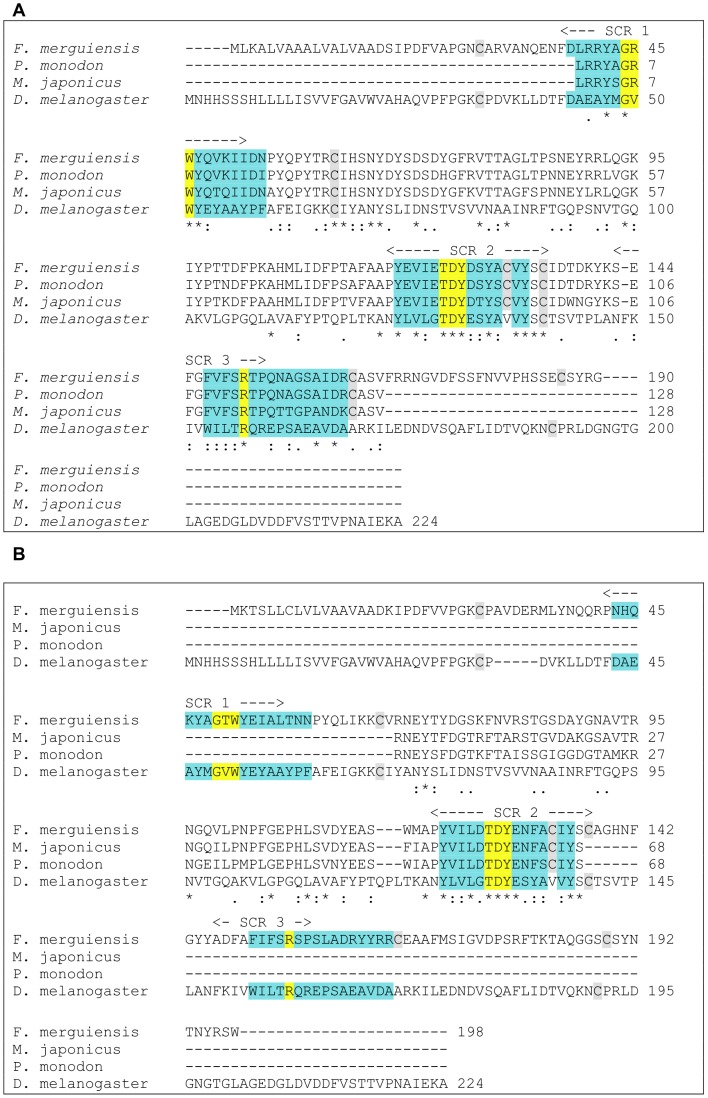
Protein alignment of lipocalins.
Drosophila melanogaster neural lazarillo (GenBank: AAF51378) protein sequence aligned with a) deduced F. merguiensis crustacyanin subunit A protein sequence (GenBank: HM370278), partial P. monodon (GenBank: ACL37117) and M. japonicus (GenBank: ACL37116) crustacyanin subunit A protein sequences, and b) deduced F. merguiensis crustacyanin subunit C protein sequence (GenBank: HM370279), partial P. monodon (GenBank: ACL37123) and M. japonicus (GenBank: ACL37122) crustacyanin subunit C protein sequences. Blue highlighted segments correspond to motifs with the yellow inserts marking the conserved amino acids in these motifs. SCR stands for structurally conserved region, and grey highlights the six cysteine residues.